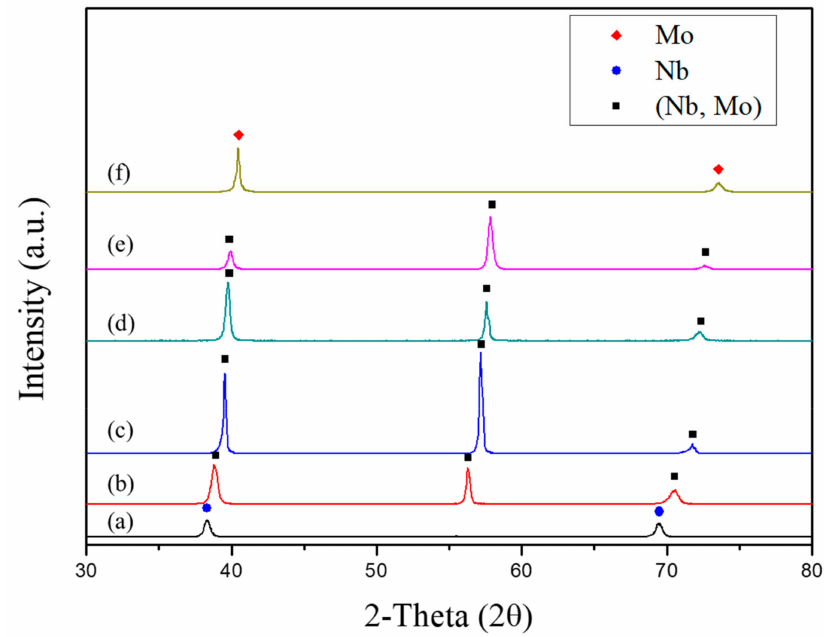
Figure 1. XRD patterns of the as-cast Nb–Mo alloys with the compositions of ( a ) Alloy 1 (Nb), ( b ) Alloy 2 (Nb 73.6 Mo 26.4 ), ( c ) Alloy 3 (Nb 51.2 Mo 48.8 ), ( d ) Alloy 4 (Nb 35.1 Mo 64.9 ), ( e ) Alloy 5 (Nb 25.7 Mo 74.3 ), and ( f ) Alloy 6